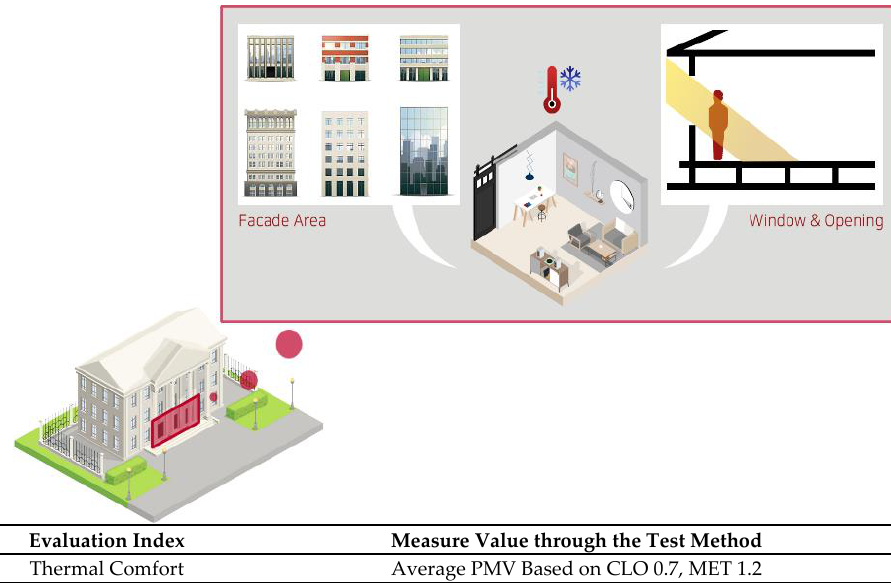
Figure 2. Spatial conditions and measurement settings of target spaces.